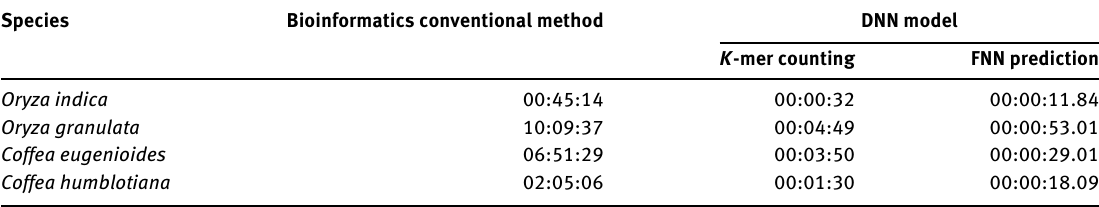
Table 5: Execution time of the conventional method and the model implemented for LTR_FINDER data.